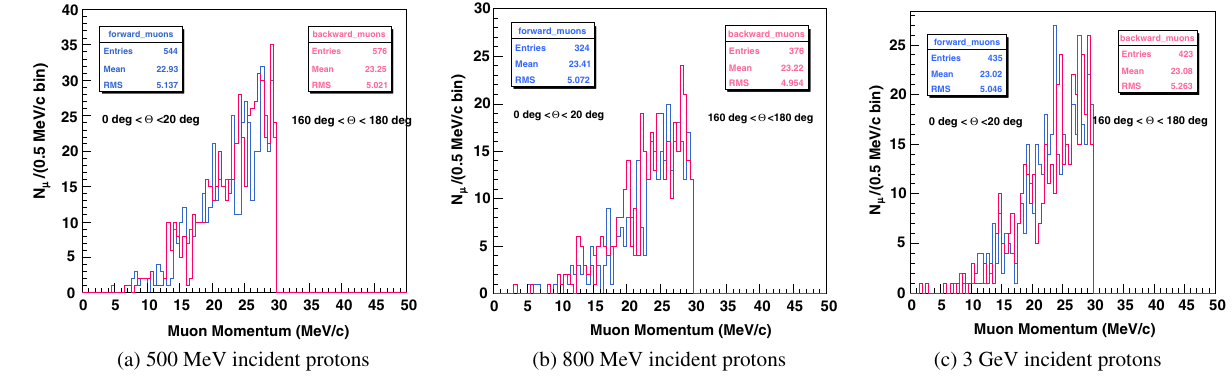
FIG. 16. Surface muon momentum distributions for various incident proton